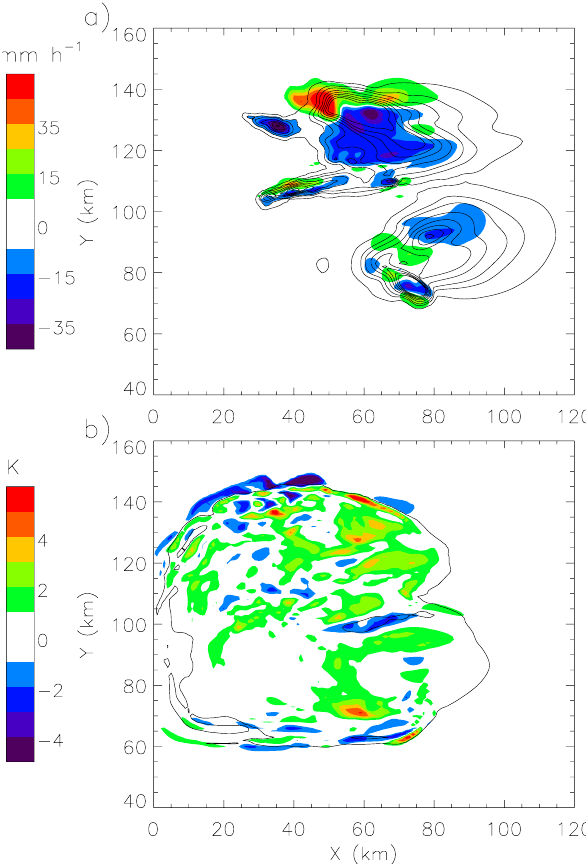
Fig. 6. (a) Surface precipitation rate and (b) lowest-level θ 0 for the BASE configuration at t = 120min. Colored contours indicate differences between polluted and pristine simulations (POLL minus PRIS). Black contour lines indicate (a) surface precipitation rate (contour interval of 5mmh − 1 , from 1mmh − 1 up to 36mmh − 1 ) , and (b) cold pool boundary (defined by the − 2K θ 0 isotherm) in PRIS at t =